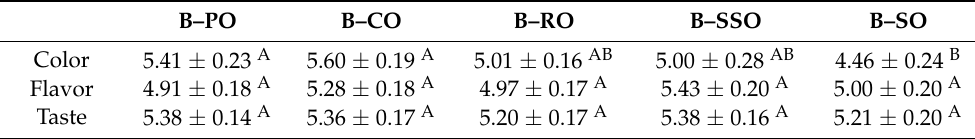
Table 5. Influence of different vegetable oils on sensory quality of fried